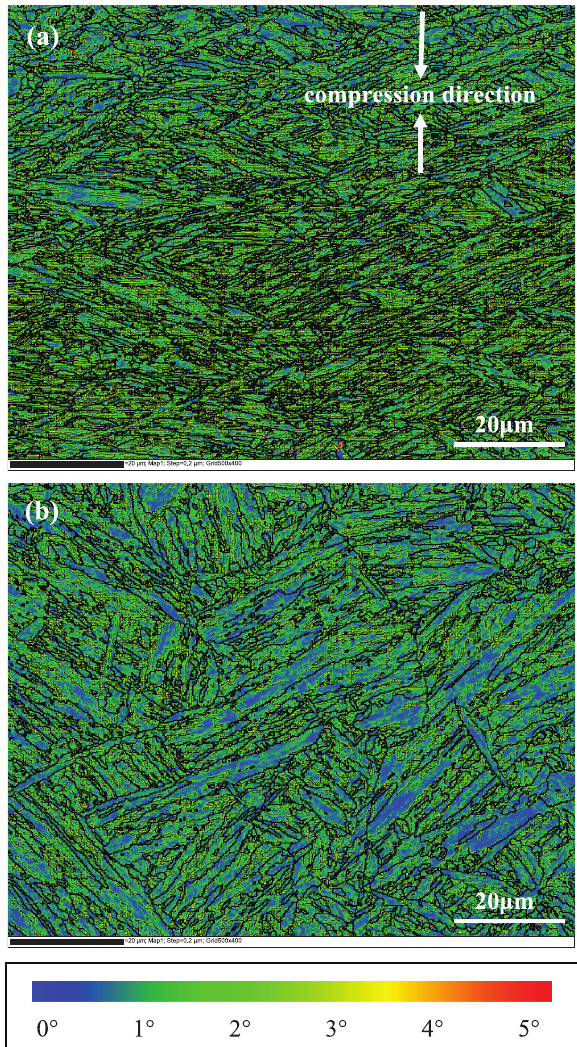
Fig. 4: Distribution of local misorientation with strain rate of 0.1 s − 1 at different temperatures: (a) 1000 °C and (b) 1150 °C. The grain boundaries are superimposed. Thin lines correspond to low angle grain boundaries (2–15°) and thick lines to high angle grain boundaries ( >